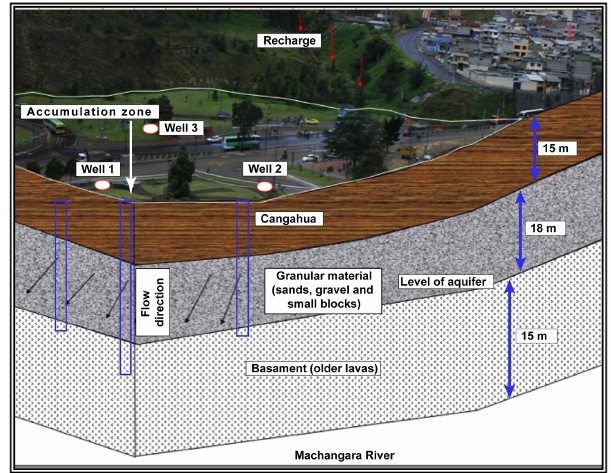
Figure 7. Conceptual model of the aquifer with the site of the wells and the flowing direction.